Question: Generate an informative caption for the figure above.
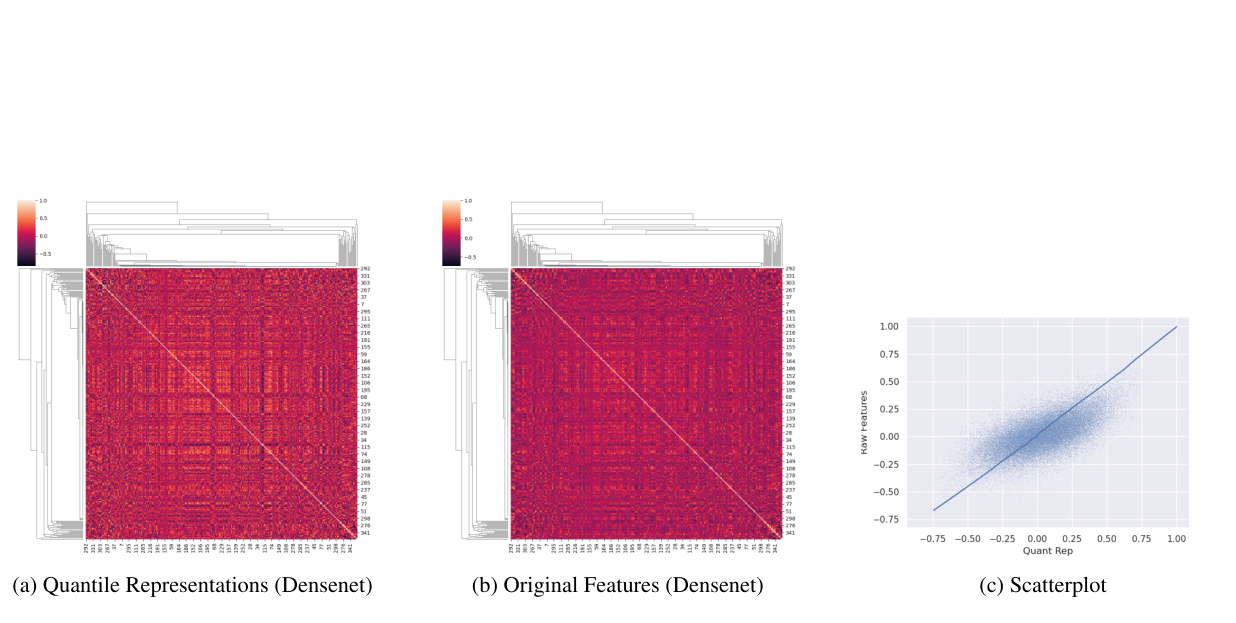
Answer: Do quantile representations capture the relevant information for classification? (a) Cross-correlations obtained using Quantile representations for Densenet on CIFAR10 (b) Cross-correlations obtained using train features for Densenet on CIFAR10. (c) Scatterplot with best fit line (using Locally Weighted Scatterplot Smoothing[Cleveland, 1979]) of the cross-correlations. Observe that as the correlation becomes important (i.e close to −1 or 1) quantile representations are more consistent with raw features.